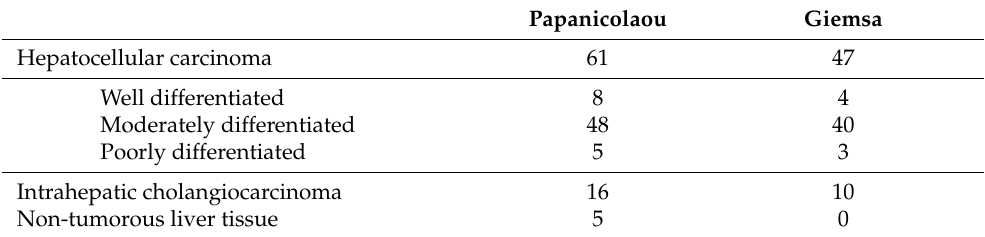
Table 1. Details of Touch Smear Cytology of Resected Specimens.